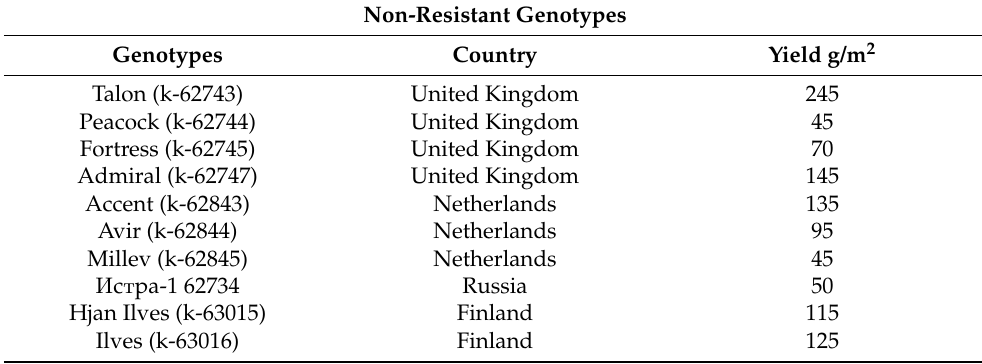
Table 4. Yield of the non-resistant genotypes